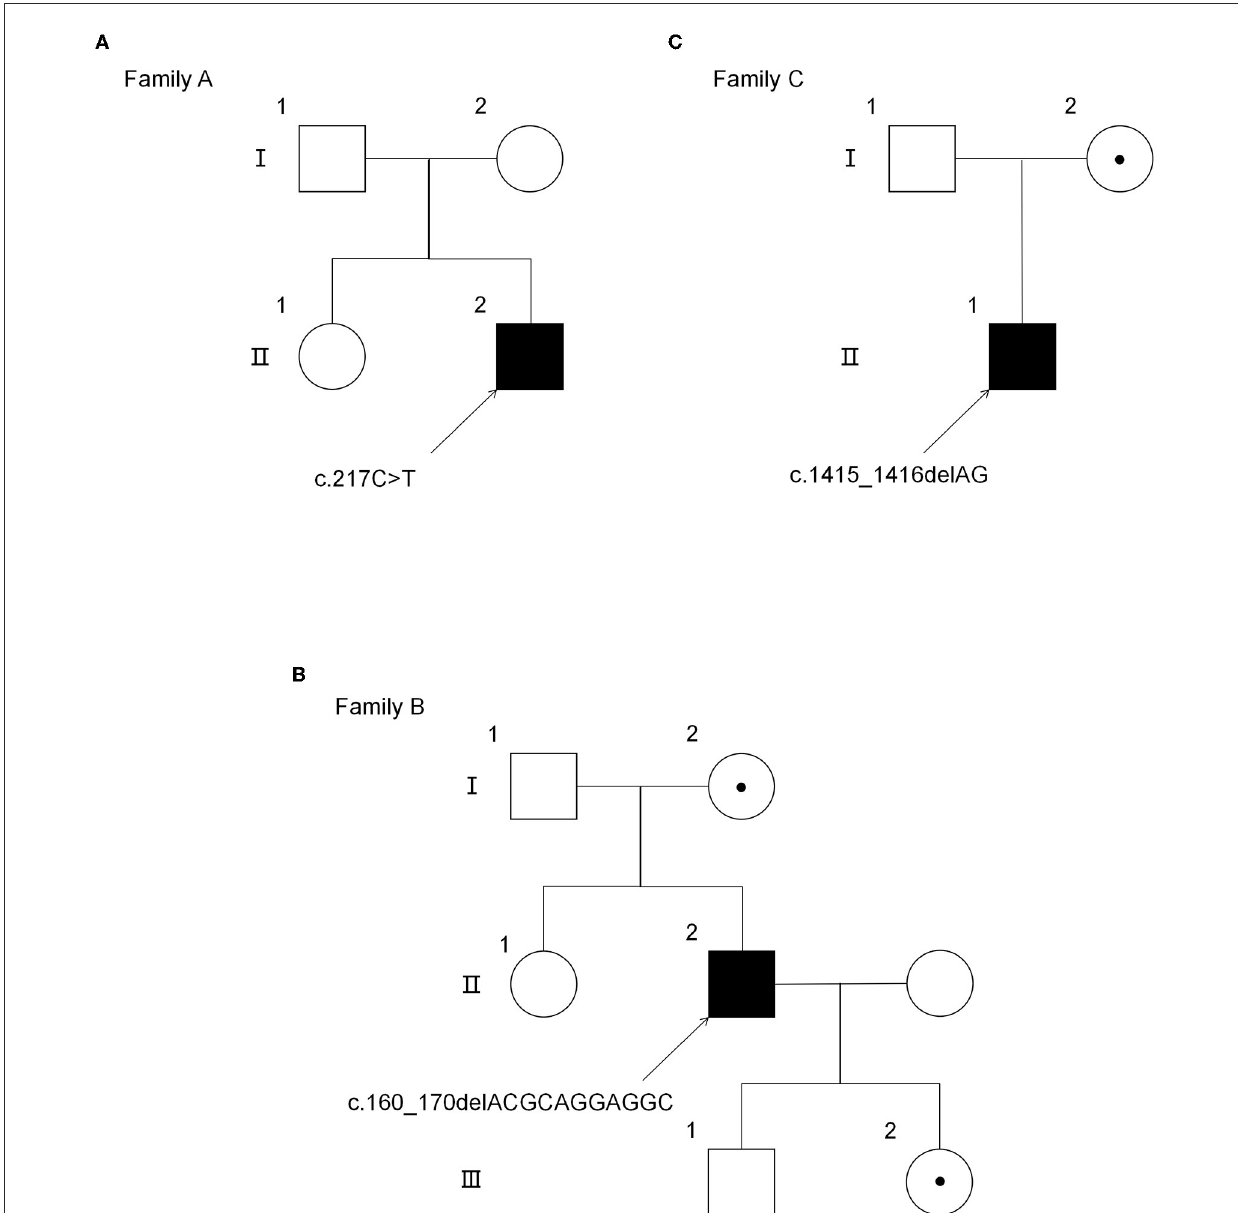
FIGURE1 Pedigree of three AMN families. (A) The pedigree of the AMN family with the mutation p.Gln73*. (B) The pedigree of the AMN family with the mutation p.Thr54Leufs*137. (C) The pedigree of the AMN family with the mutation p.Gln472Argfs*83. *Premature stop